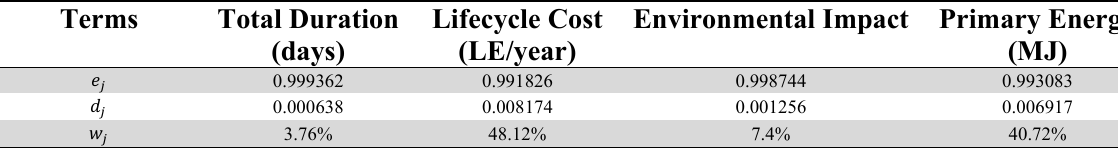
Entropy value, variation coefficient and weight of attributes